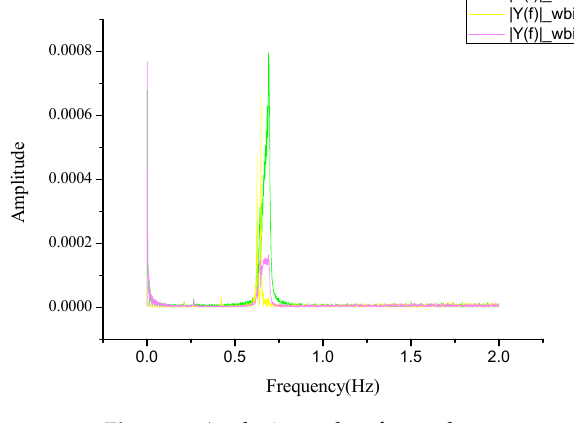
Figure 9. Analysis results of gyro data.